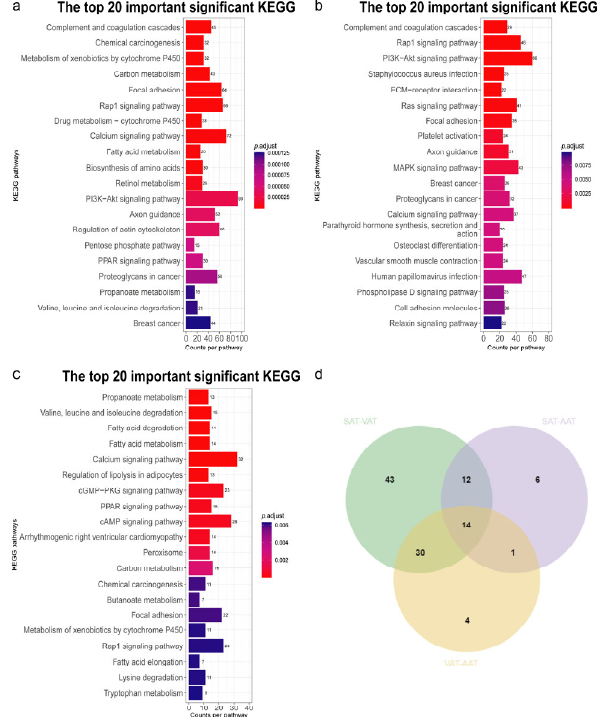
Figure 4. KEGG pathway enrichment of differentially expressed genes. ( a – d ) represent the enrichment and intersection of the KEGG pathway enriched by SAT ‐ VAT, SAT ‐ AAT, and VAT ‐ AAT, respectively. Table 1. The overlapped significant pathways enriched by differentially expressed genes identified in SAT ‐ VAT, SAT ‐ AAT, and VAT ‐ AAT groups.